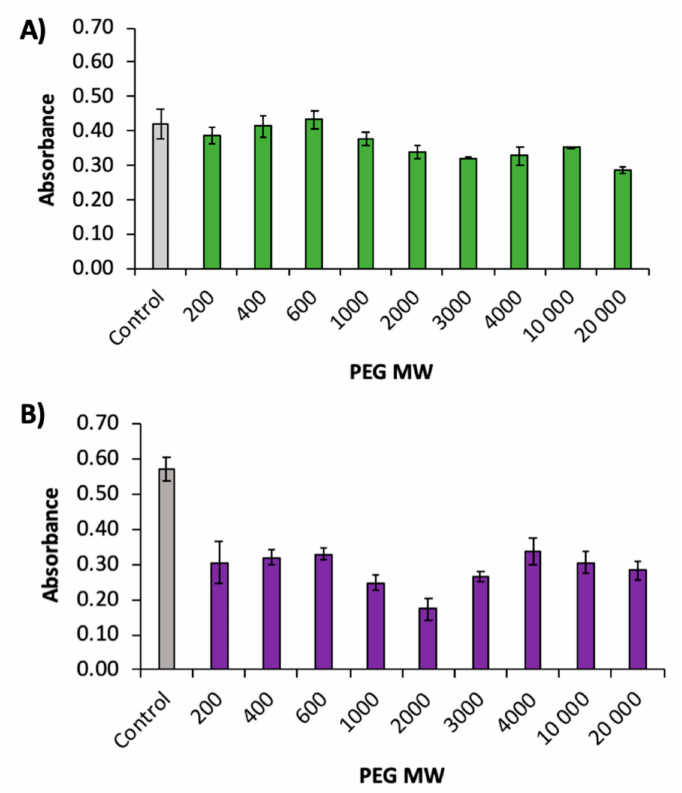
Figure 2. Change in absorbance of the FC assay upon binding to di ff erent PEG MW for purified phlorotannins from ( A ) A. nodosum and ( B ) F. serratus extracted from samples collected in